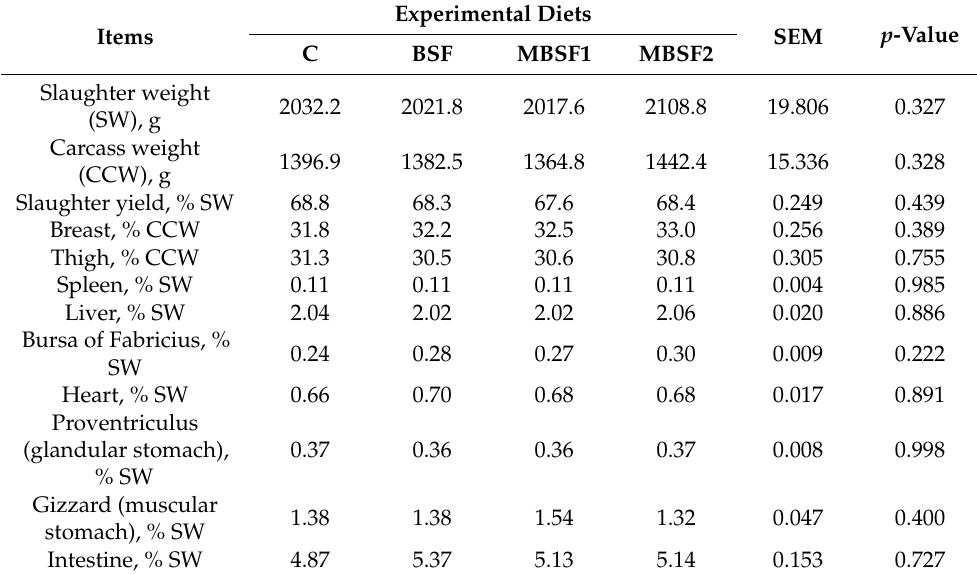
Table 5. Effect of black soldier fly larvae fat on slaughter performance of broiler chickens (n = 15/treatment).